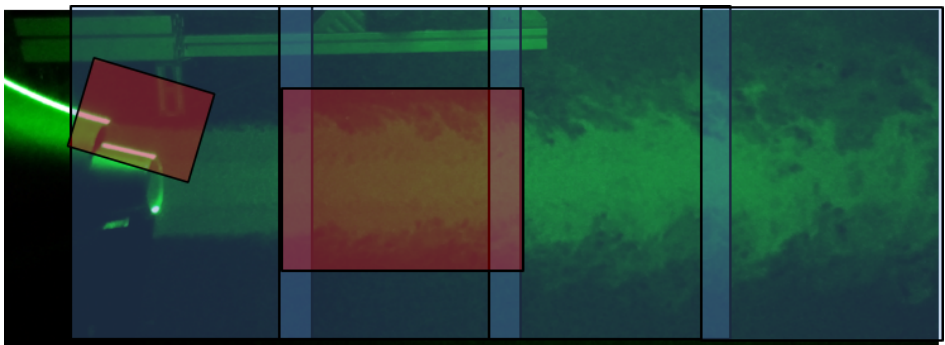
Figure 26. Sketch of the fields of view investigated with PIV. The two green frames on the left are not correlated with the two on the right. The regions enclosed in the red frames, as for the single jet, have been investigated with higher resolution.